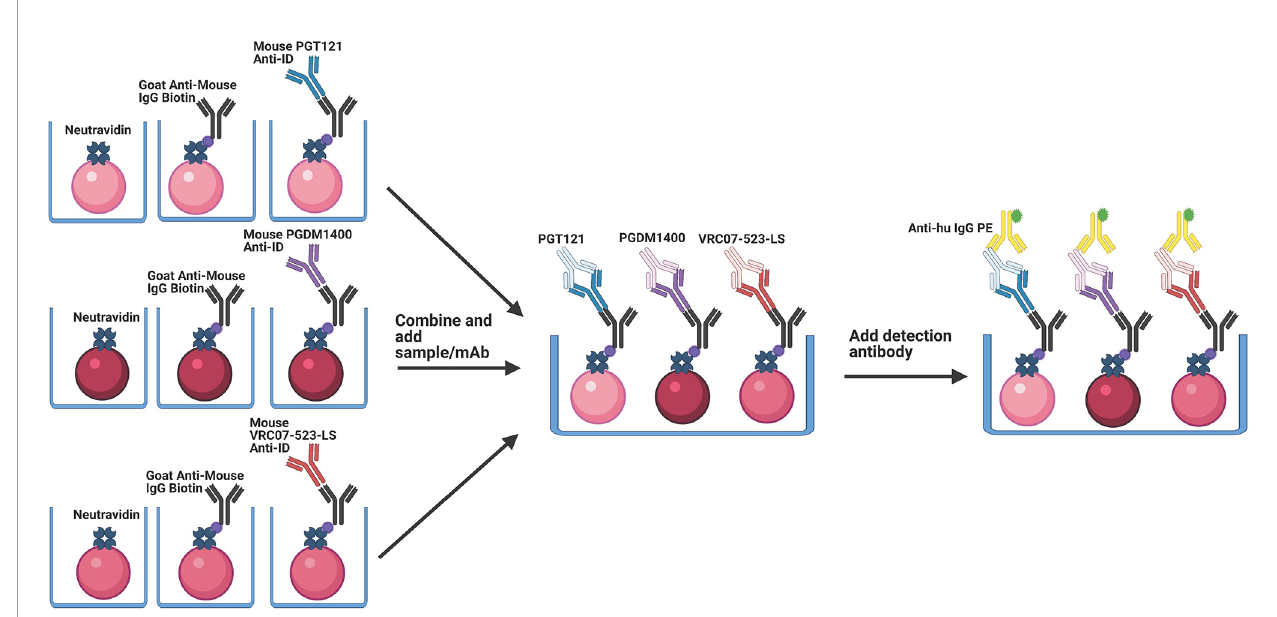
FIGURE 1 | Schematic of the Triplex PK setup. Magnetic microspheres are coupled to NeutrAvidin, which binds to the biotin conjugated goat anti-mouse IgG. This antibody is in an orientation that allows for binding of the anti-ID antibody in the correct orientation to allow for optimal binding of the corresponding mAb. In a multiplex setup, the anti-ID antibodies are bound to the goat anti-mouse IgG Biotin in separate reactions, are washed, and then combined. PGT121, PGDM1400 and VRC07-523-LS mAbs are then added simultaneously into the solution. The microspheres are then washed, and detection antibody is